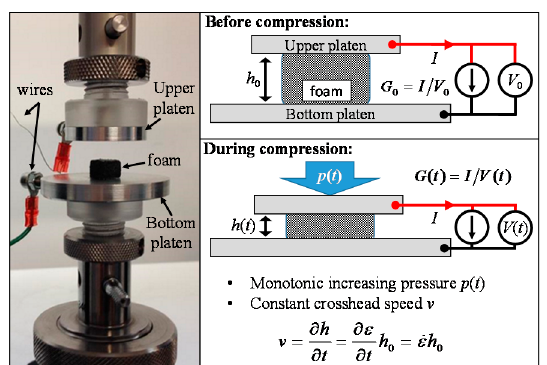
Figure 12. Adopted parallel compression platen system for the pressure tests and corresponding sketch of the electromechanical measurements.